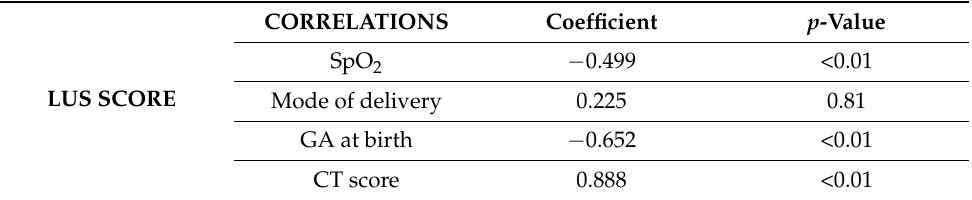
Figure 5. CHEST CT shows extensive interstitial pneumonia on the axial plane ( a ) with crazy paving pattern and consolidation area. Multiplanar reconstruction (MPR) on coronal and sagittal planes ( b , c ) demonstrate scissure thickening and fibrosis. Table 4. Correlation between LUS score, CT score, mode of delivery (vaginal or cesarean delivery), gestational age (GA), and partial saturation of oxygen (SpO 2